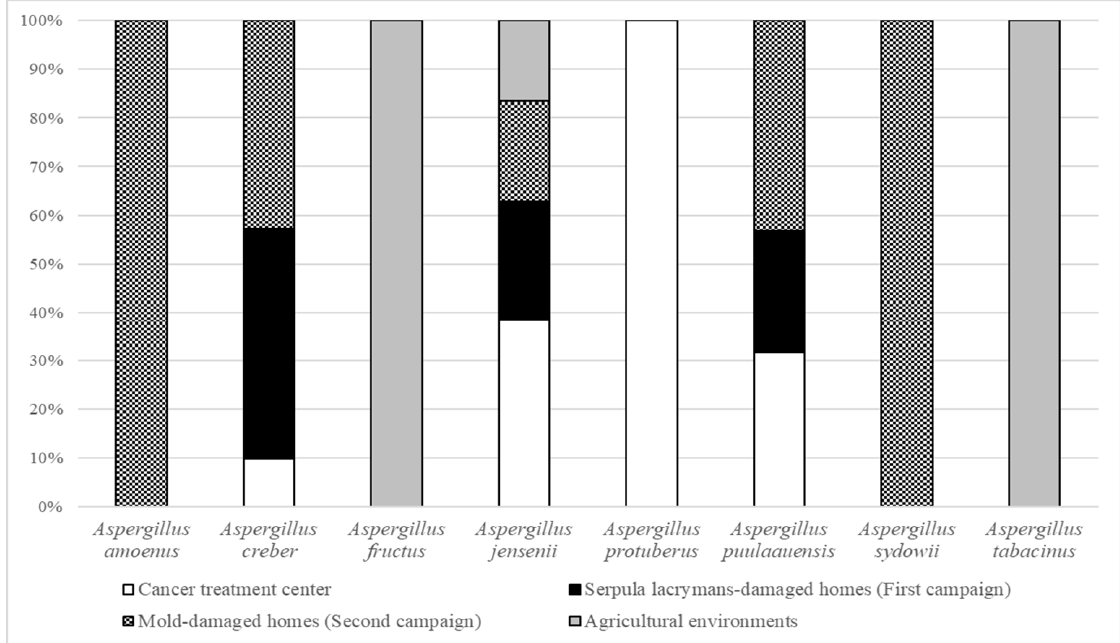
Figure 1. Relative abundances of Aspergillus species in the Versicolores series depending on bioaerosols’ sampling location.